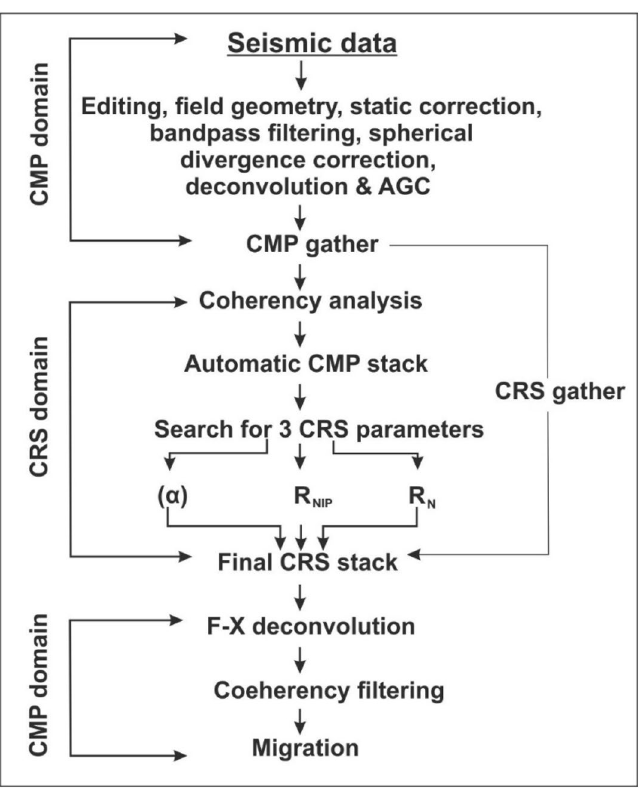
Figure 4. CRS data processing flow chart. α—the angle of emergence, R NIP —radius of curvature of normal incidence point wave, and R N —radius of curvature of the normal